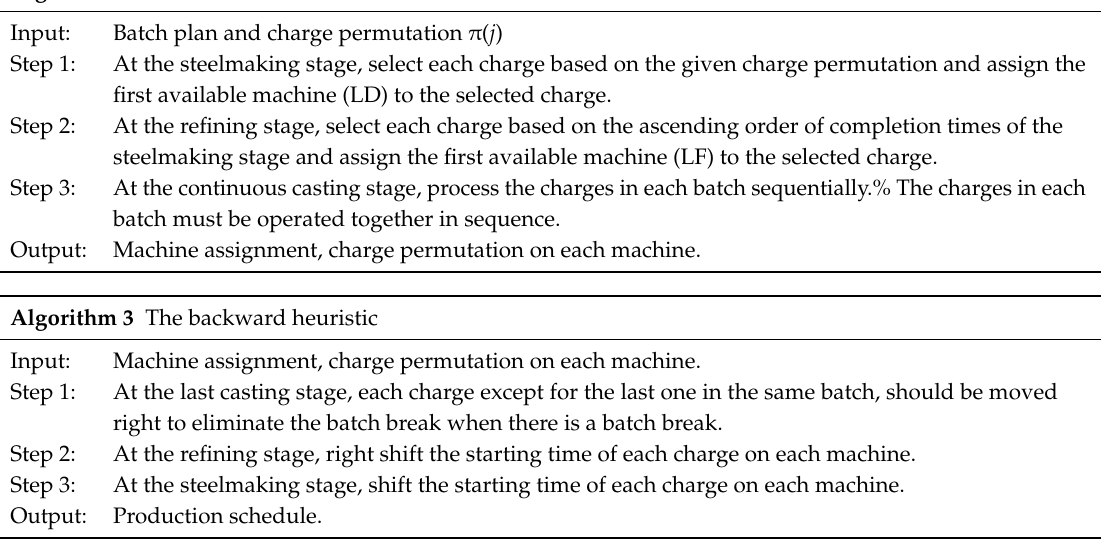
Algorithm 2 The FIFO-based forward heuristic